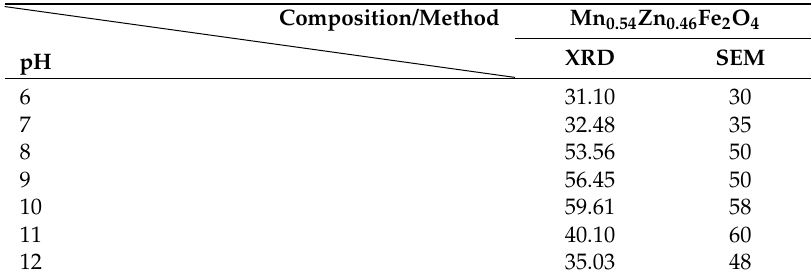
Table 2. The effect of pH on the mean diameter.